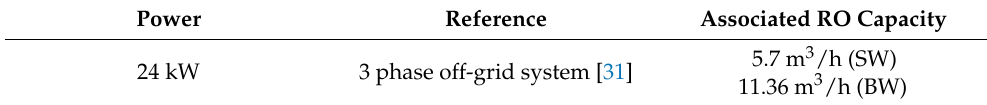
Table 3. Maximum capacities of inverters and the associated RO